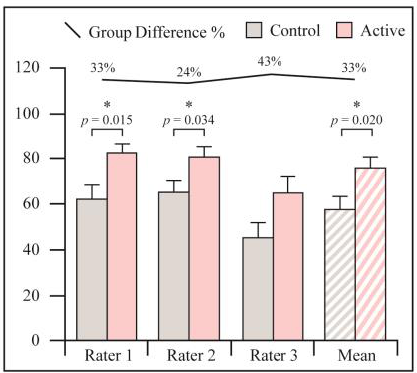
Figure 3. Radiological assessment of percentage of the extent of fracture union at 4 weeks as assessed by CT. Graphs are reported as mean ± SE. Student’s t -test. * Statistically significant.